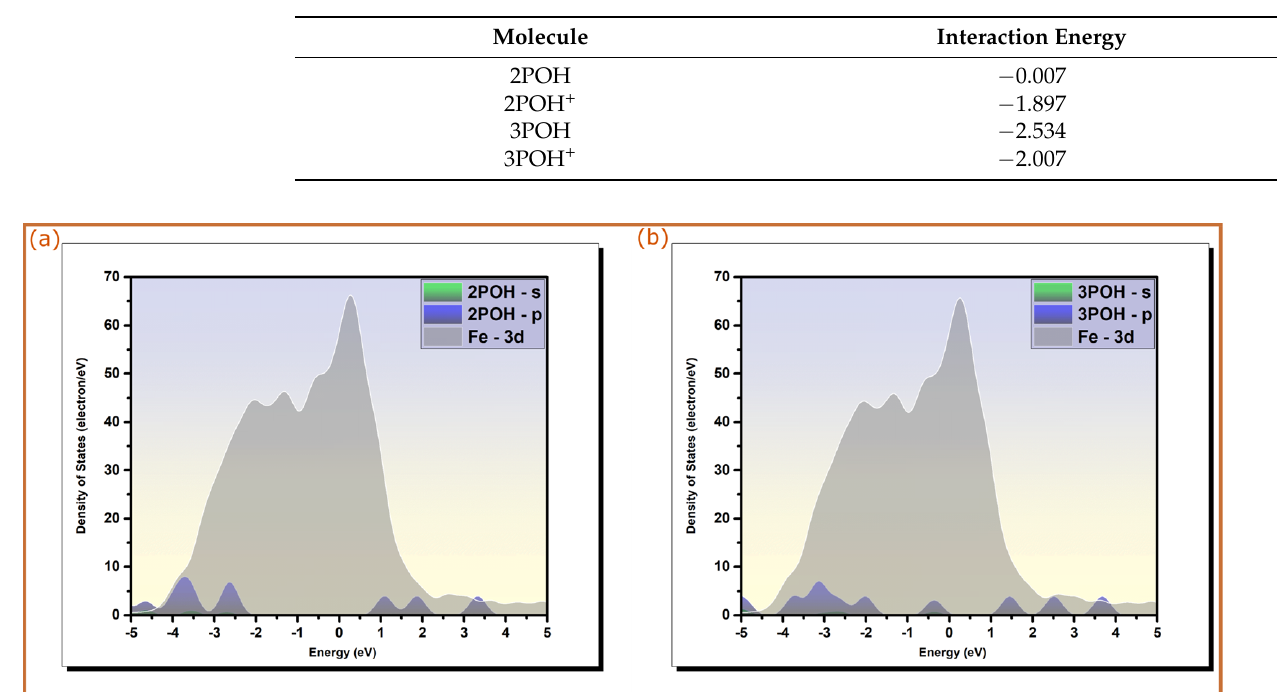
Figure 3. Projected density of states of isolated pyridine molecules on Fe(110) surface (7 Å above the top iron layer); ( a ) 2POH and ( b ) 3POH. Fermi energy (EF) is chosen as the zero energy level.